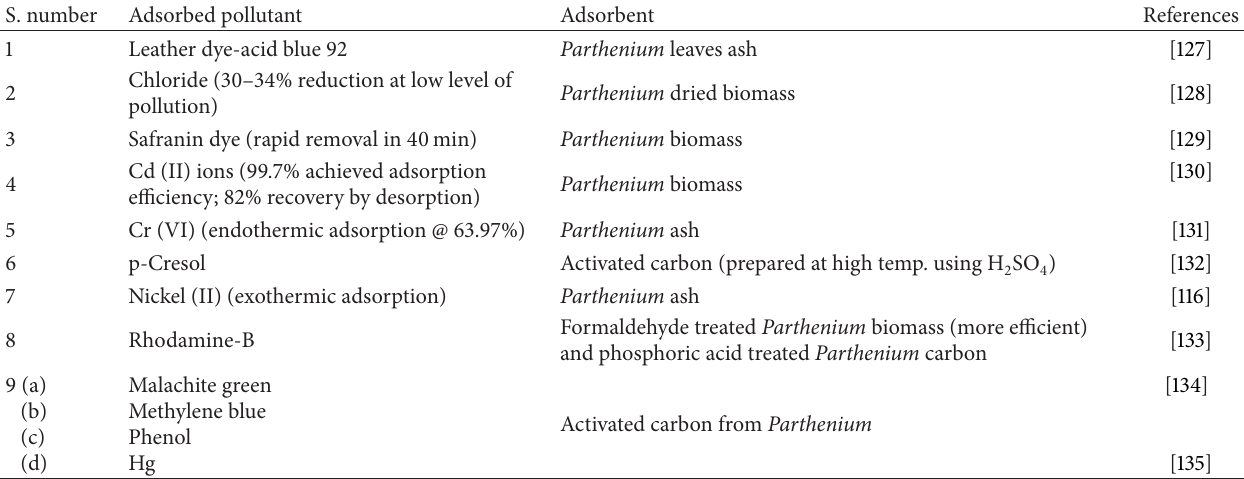
Table 2: Bioadsorption of pollutants by Partheniumhysterophorus